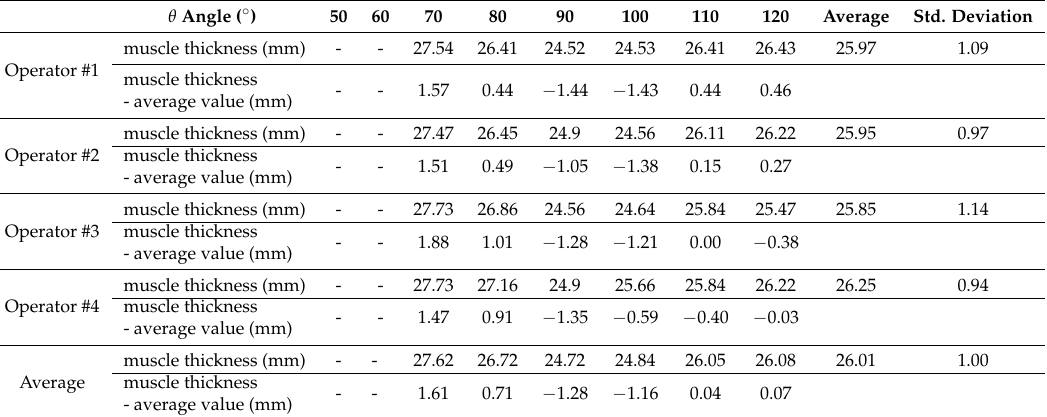
Table 4. Muscle thickness measurement